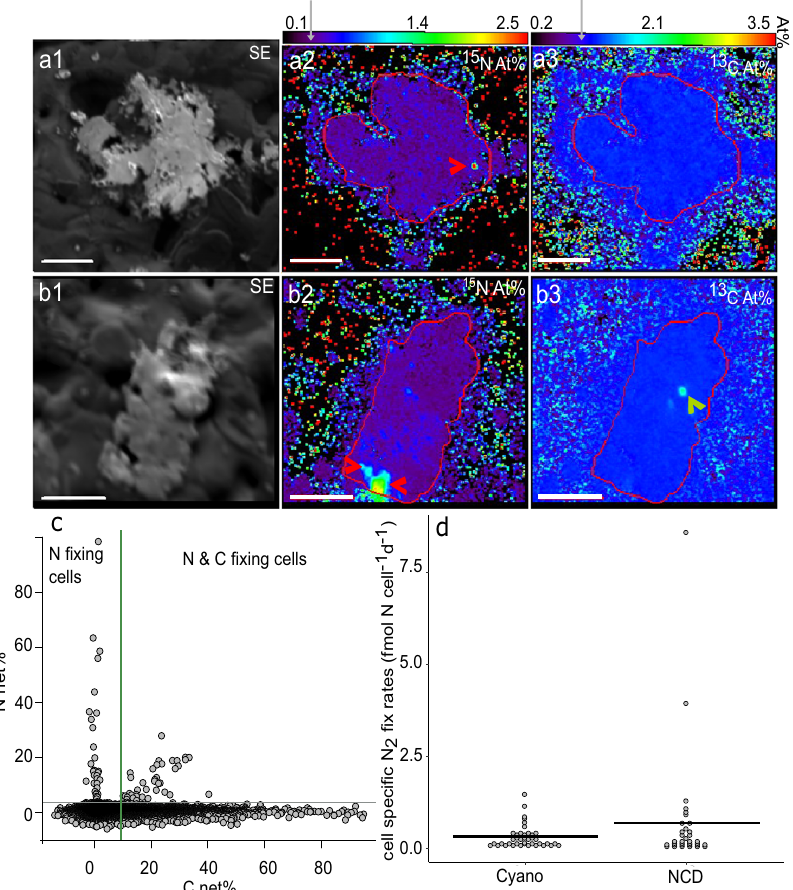
Fig. 3 | NanoSIMS data.a , b Example images of two particles with associated NCD ROIs. Images show particles using secondary electrons (a1, b1) with attached ROIs enrichedin 15 N(redarrows,a2andb2)butnotenrichedin 13 C(a3andb3).Atotalof 32 NCD-like ROIs were found associated with 9 particles. Red lines outline the particleshapebasedonsecondaryelectron(SE)image.Colorscalebarscorrespond to At% enrichment for the given isotope, grey arrows on color scale bar indicate natural abundance of rare isotope. The green arrow shows an ROI enriched in 13 C but not 15 N,similar to whatwe wouldexpect fornon-diazotrophicautotrophs (b3). Over 5700 non-diazotrophic autotroph-like ROIs were found across 7 stations. Scalebar is5 µ m. c Cnet% versus Nnet% of ROIs ( n =39,043), lines show Cnet% and